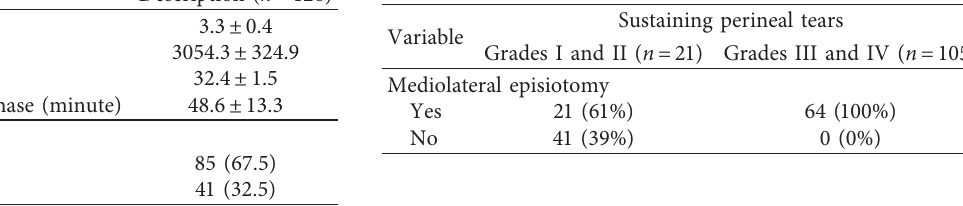
Table 4: Relationship between risk factors and perineal